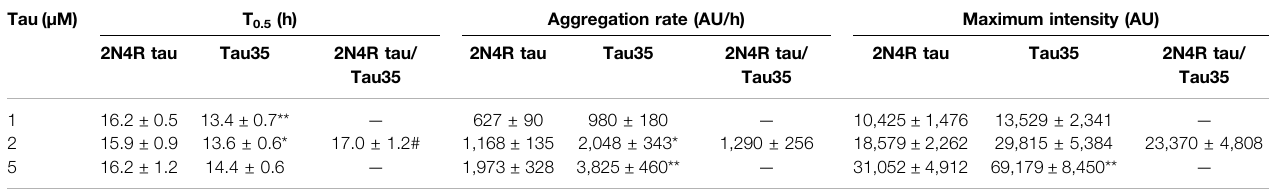
TABLE 2 | Kinetics of heparin-induced aggregation of Tau35 and 2N4R tau alone and in combination measured by ThT fl uorescence. Tau(µM) T 0.5